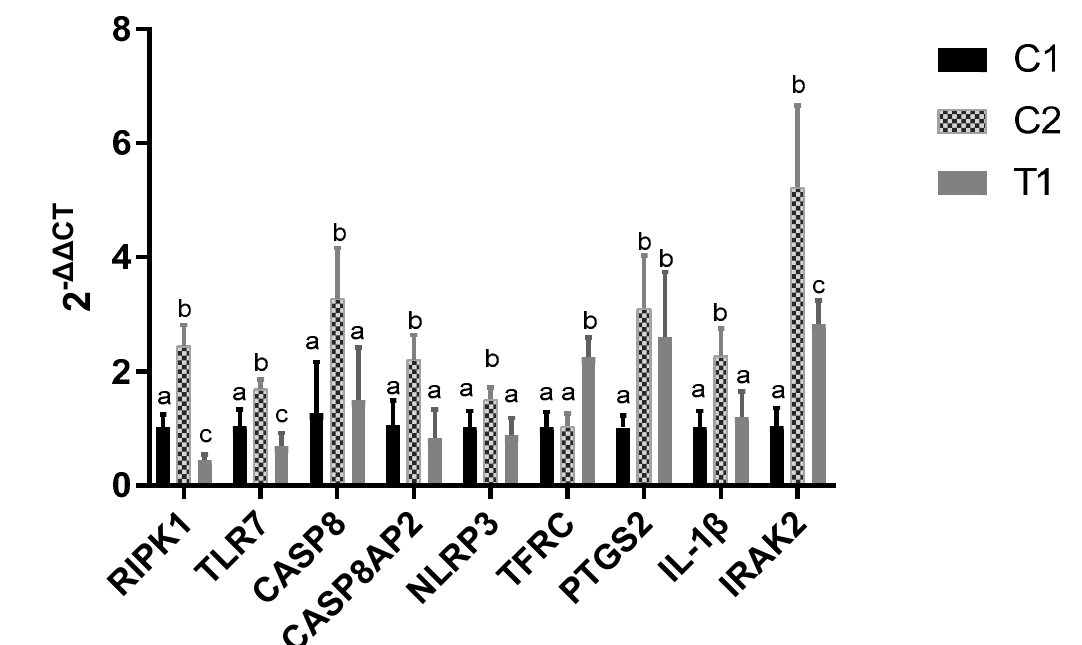
Figure 9. Relative expression of nine DEGs in the three groups. One-way ANOVA with Tukey’s test was applied. Data are expressed as mean ± SD. The same letter means no significant difference ( p > 0.05), while different letters mean significant difference between groups ( p < 0.05). C1 means control group, C2 means H 2 O 2 treatment and T1 means vitamin E and H 2 O 2 treatment. RIPK1 , Receptor-Interacting Protein Kinase 1; TLR7 , Toll Like Receptor 7; CASP8 , caspase 8; CASP8AP2 , Caspase 8 Associated Protein 2; NLRP3 , NLR family pyrin domain containing 3; TFRC , Transferrin Receptor; PTGS2 , Prostaglandin-Endoperoxide Synthase 2; IL-1 β , Interleukin 1 Beta; IRAK2 , Interleukin 1 Receptor Associated Kinase 2.